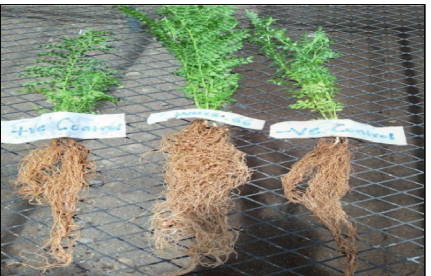
Figure 2: Effect of rhizobial inoculation on nodulation.